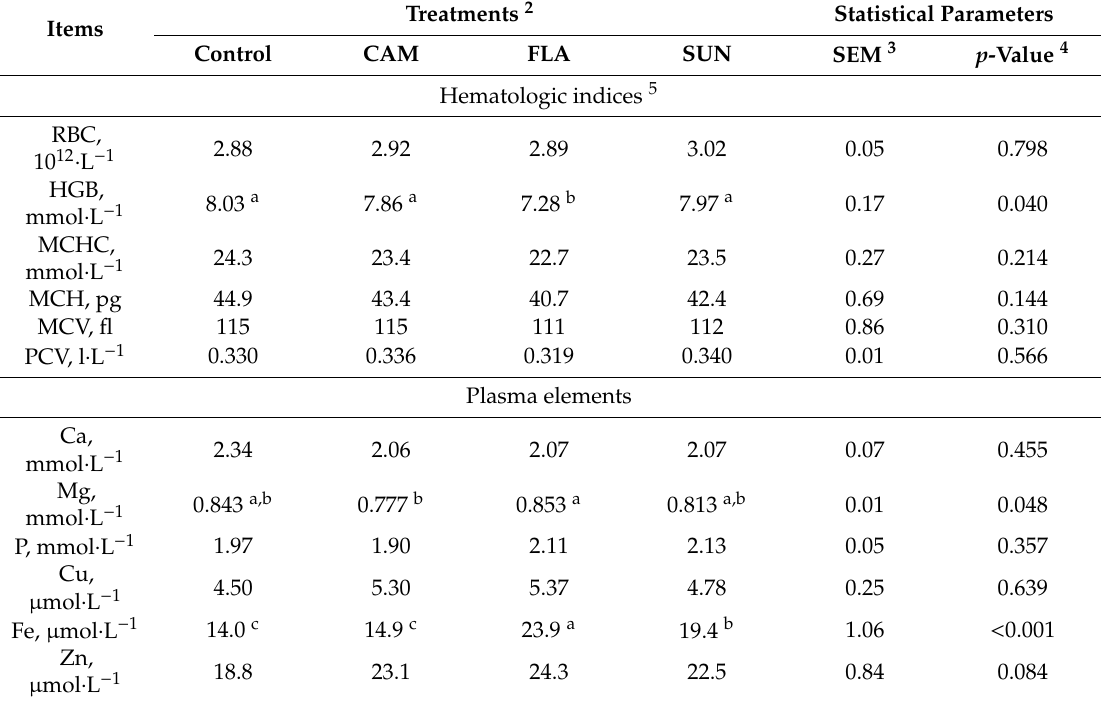
Table 7. E ff ect of dietary inclusion of full-fat seeds on hematological indices and content of plasma elements in broiler chickens fed a control, camelina, flax, and sunflower diet 1 . Treatments 2 Statistical Items